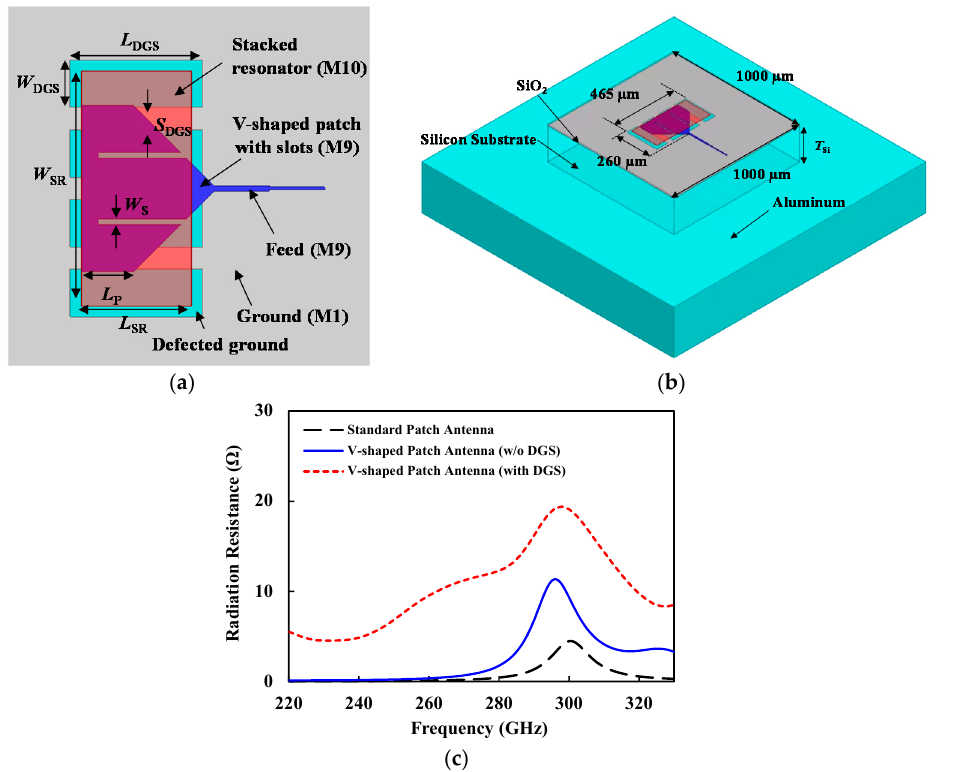
Figure 5. ( a ) Top view of the proposed V -shaped patch antenna with a defected ground structure (DGS); ( b ) HFSS simulation model of the proposed on-chip antenna, including the backside metal (aluminum); ( c ) Simulated radiation resistance of the patch antennas.